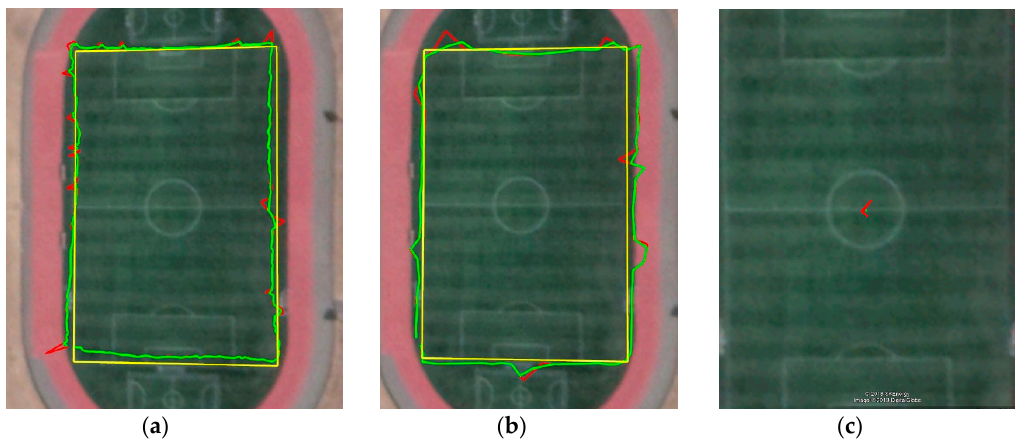
Figure 5. Visualized uncorrected experiment results for three activity conditions: ( a ) walking, ( b ) running, ( c ) resting.